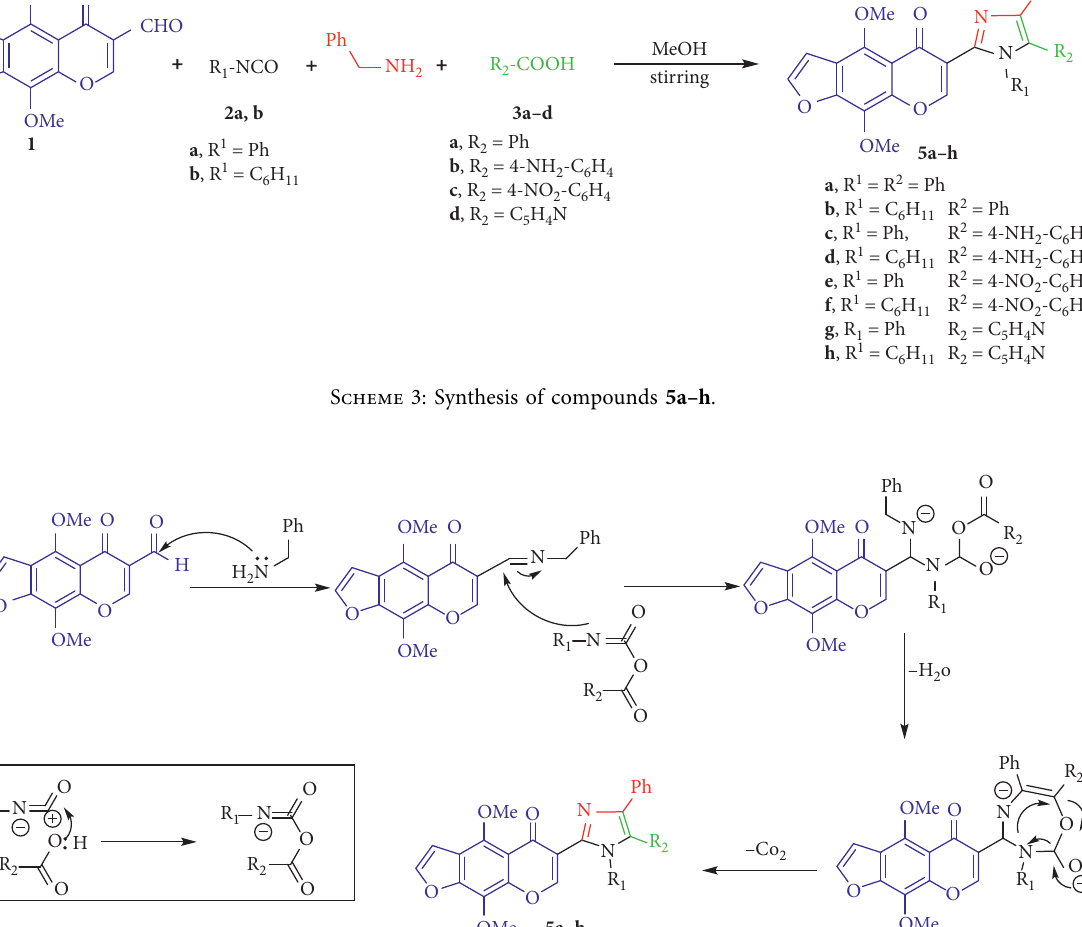
Scheme 2: Proposed mechanism for formation of compounds 4a–h .